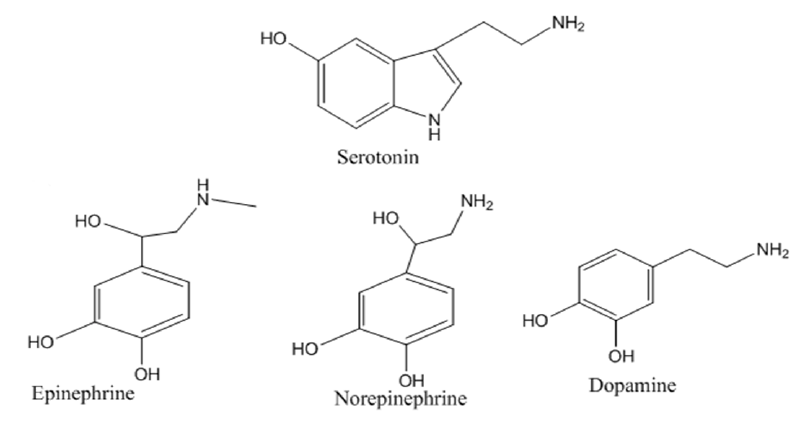
Figure 1. Monoamine neurotransmitters.